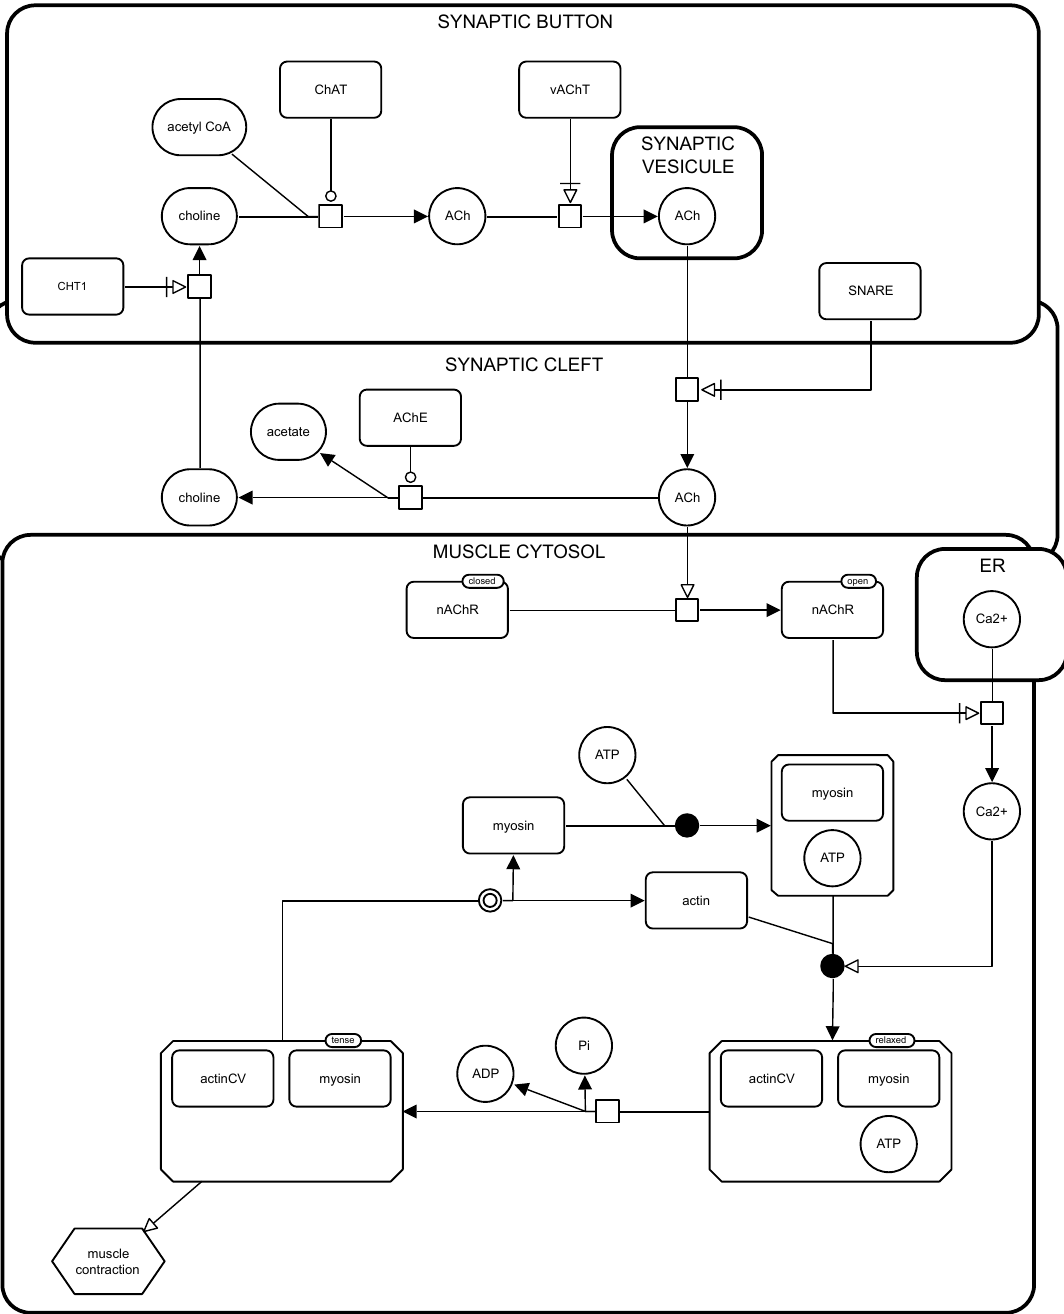
Figure A.4: Neuronal/Muscle signalling. A description of inter-cellular signalling using